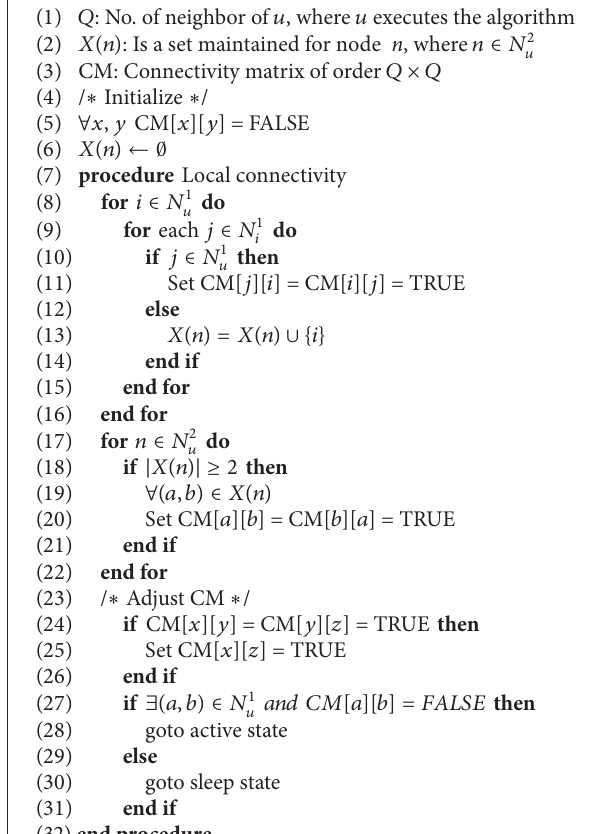
Table 4: Simulation